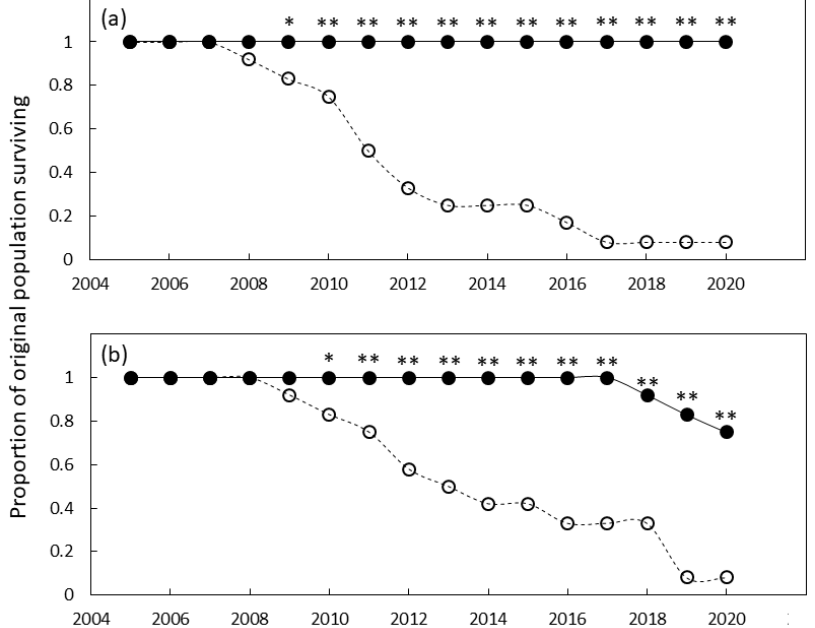
Figure 2. The proportion of original Cycas micronesica plants remaining alive over a 15 y growth period in ( a ) south Guam garden and ( b ) north Guam garden. Closed circles are local genotypes, open circles are foreign genotypes. * = significant at p ≤ 0.05, ** = significant at p ≤ 0.01.